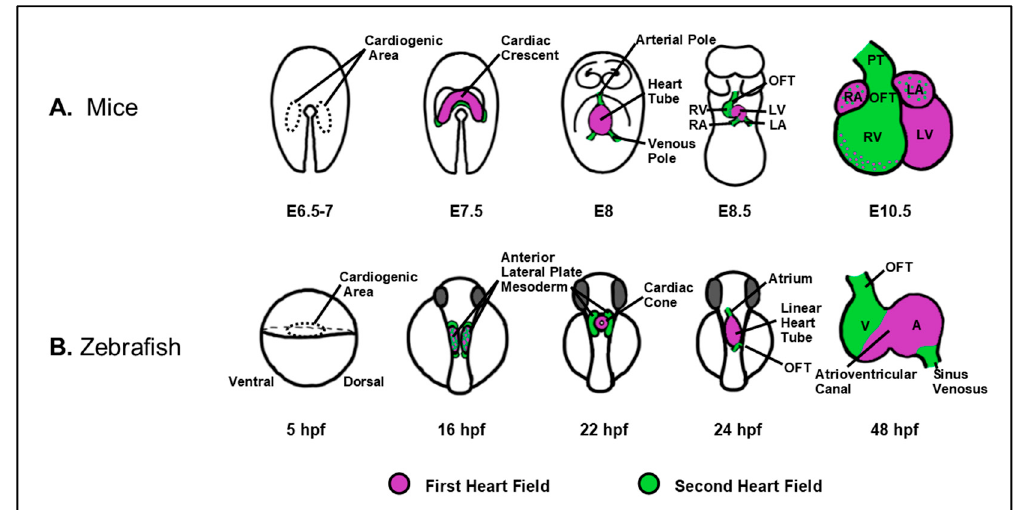
Figure 2. Vertebrate cardiac development proceeds via the contribution of waves of differentiating progenitors, as depicted in mice ( A ) and zebrafish ( B ). During early heart development, cardiac progenitors are specified bilaterally within the lateral plate mesoderm and subsequently coalesce as the cardiac crescent in mice and cardiac cone, in zebrafish. In mice and zebrafish embryos, the FHF (magenta) first forms the cardiac tube followed by contribution of the SHF (green) to the poles of the developing heart. Subsequently, the heart undergoes an expansion process, including ballooning of the cardiac chambers, looping, and the generation of the septa in the case of a four ‐ chamber heart. A: atrium; E: embryonic day; HPF: hours post ‐ fertilization; LA: left atrium; LV: left ventricle; OFT: outflow tract; PT: pulmonary trunk; RA: right atrium; RV: right ventricle; V: ventricle.